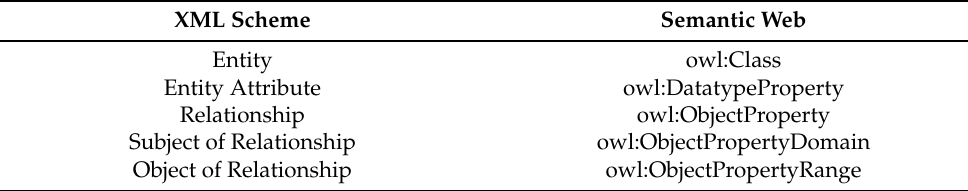
Table 5. Translations from concepts in the ontology to concepts in the SW [164].